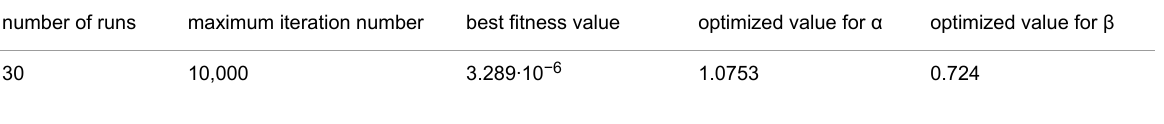
Table 1: The best values of the optimized parameters over the 30 runs. number of runs